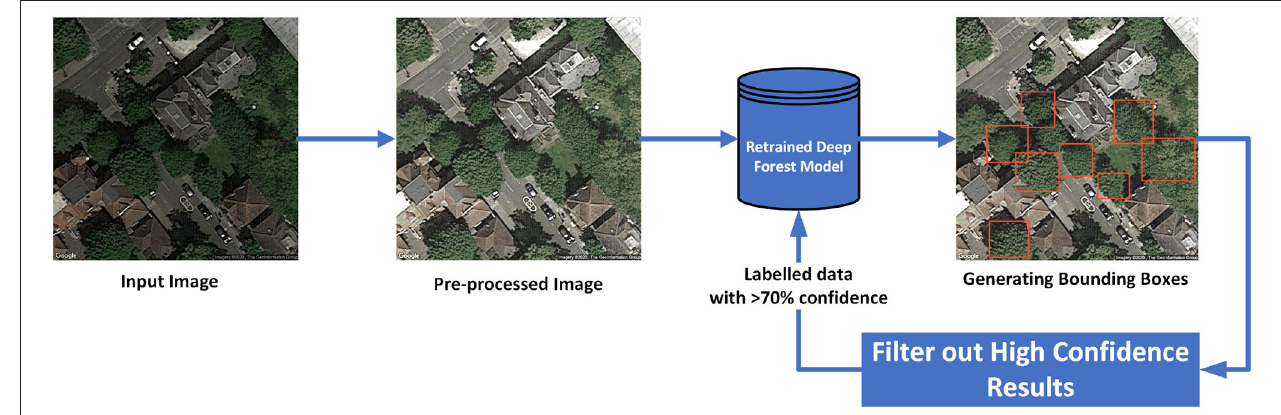
FIGURE 2 | Tree recognition framework: self supervised training approach.